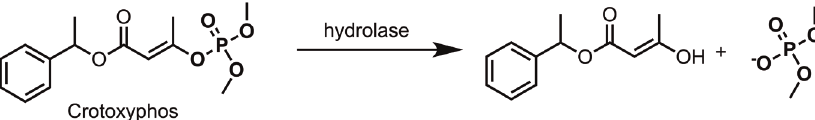
Figure 54 - Crotoxyphos degradation by